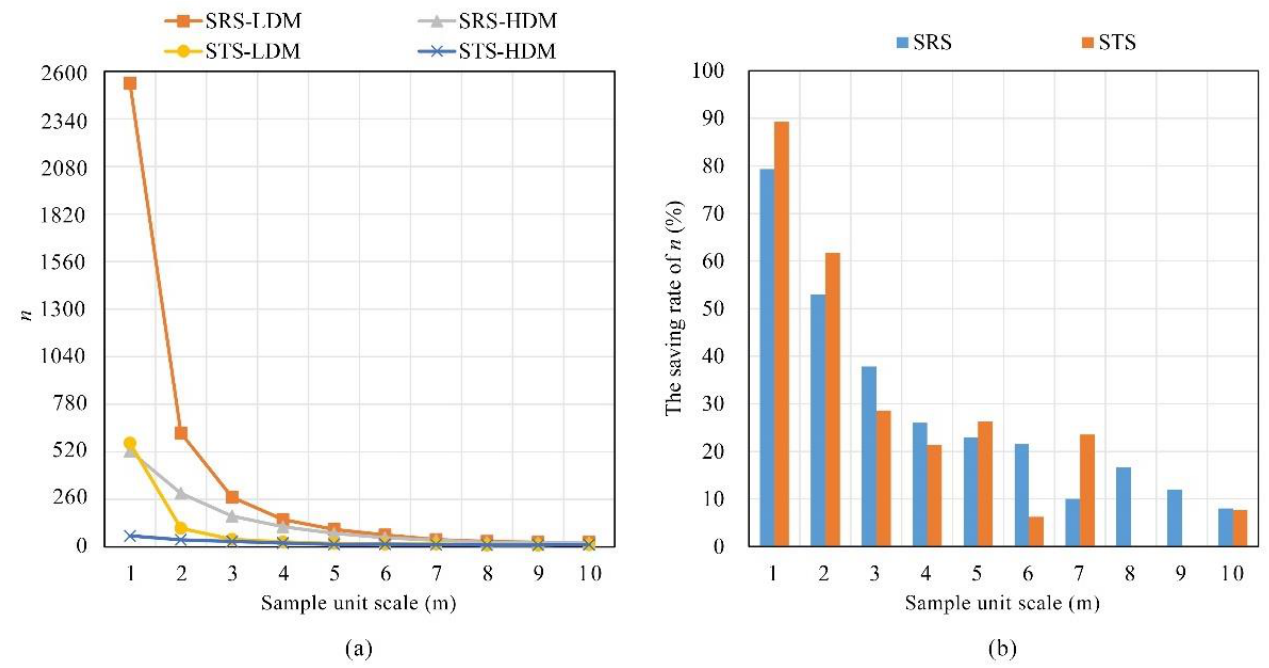
Figure 7. Effects of different biomass distribution models on the sample size. ( a ) Variation of sample size; and ( b ) The savings in the sample size of the HDM method schemes compared to the LDM method